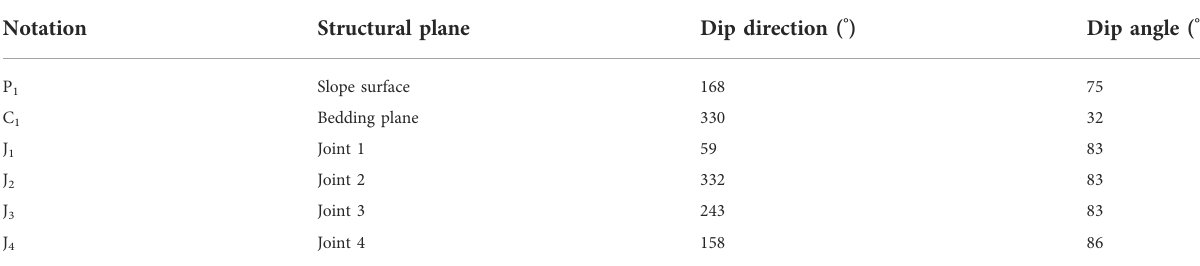
TABLE 1 Parameters for stereographic